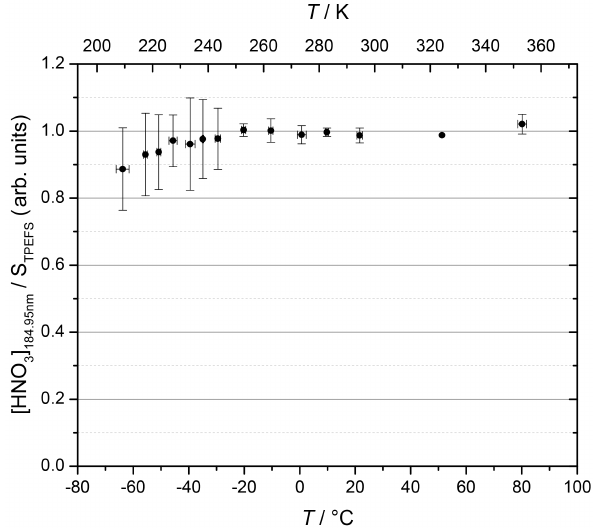
Figure 3. TPEFS detection of HNO 3 in the centre of the reactor at different temperatures. The TPEFS signal ( S TPEFS ) has been nor- malised to the HNO 3 concentration. The error bars indicate uncer- tainty derived from correction to the TPEFS signal due to quenching of fluorescence and absorption by HNO 3